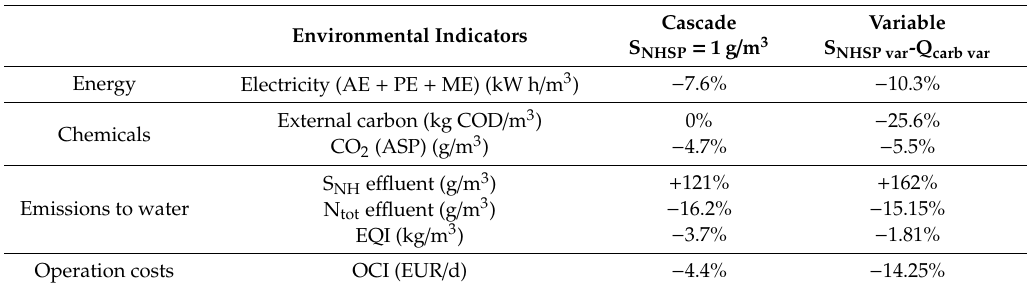
Table 14. Comparison of the influence on environmental and cost indicators of alternative strategies’ control relative to the default DO control